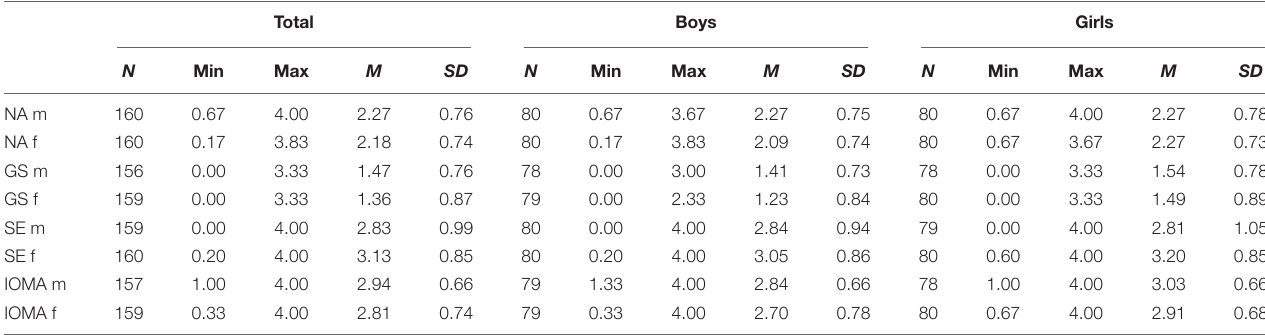
TABLE 1 | Descriptive statistics of parental variables for the total analytic sample and subsamples of boys and